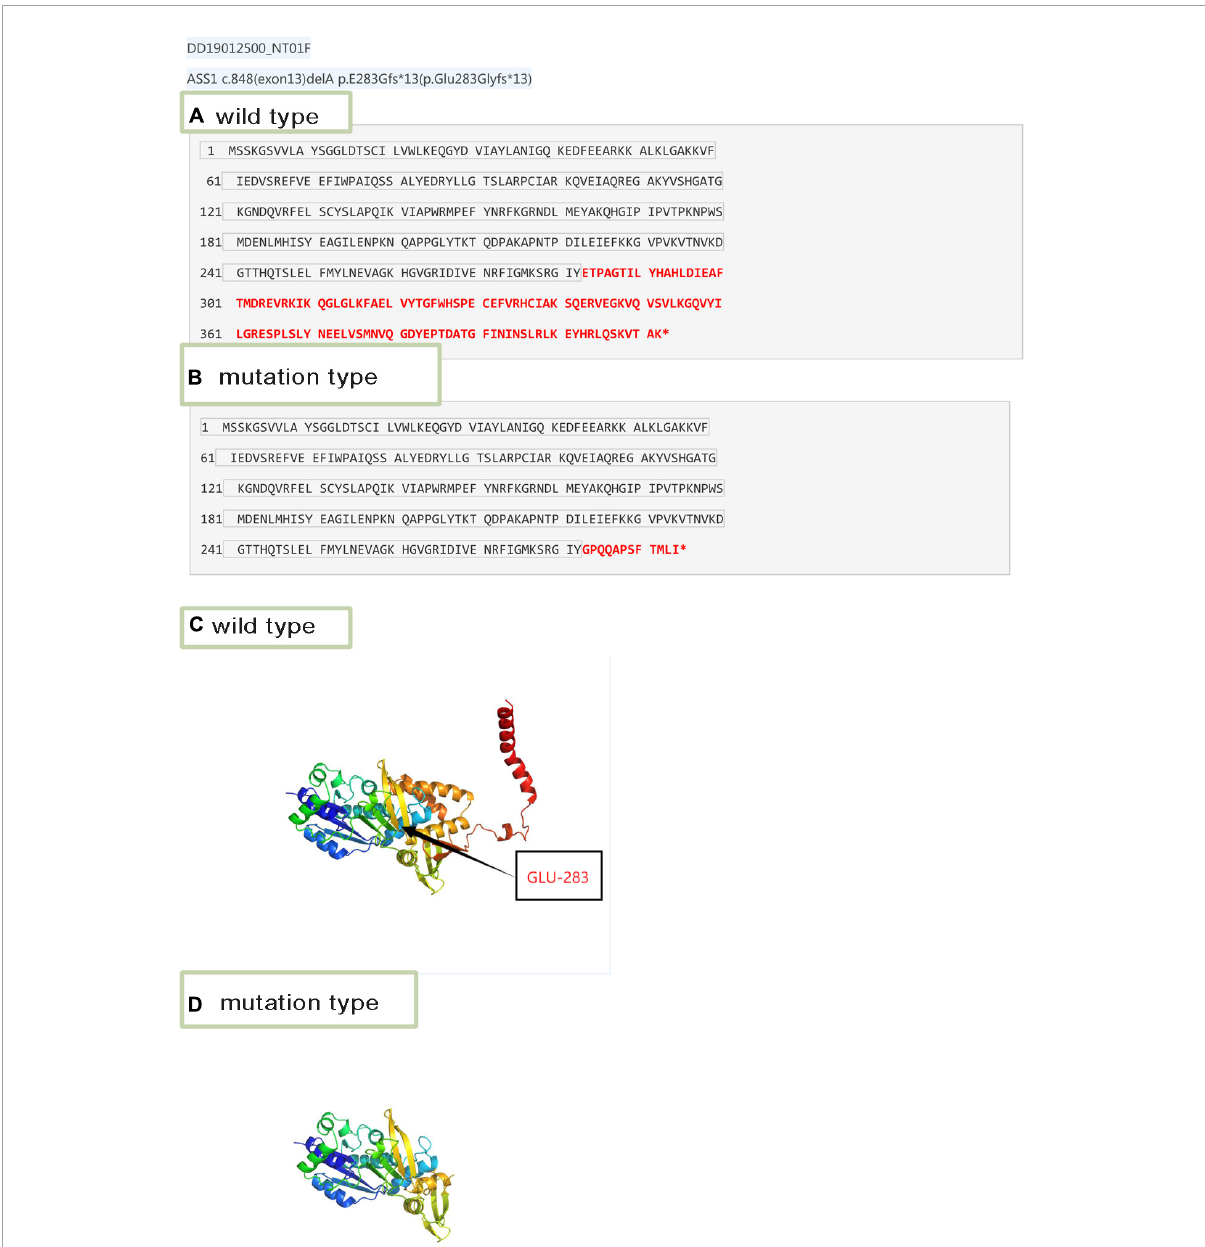
FIGURE3 Amino acid sequence and 3D structure. (A) Wild-type amino acid sequence of ASS1 :c.848delA. (B) Mutation type amino acid sequence of ASS1 :c.848delA. (C) 3D structure of wild-type of ASS1 (p.Glu283 Glyfs ∗ 13). (D) 3D structure of mutation type of ASS1( p.Glu283 Glyfs ∗